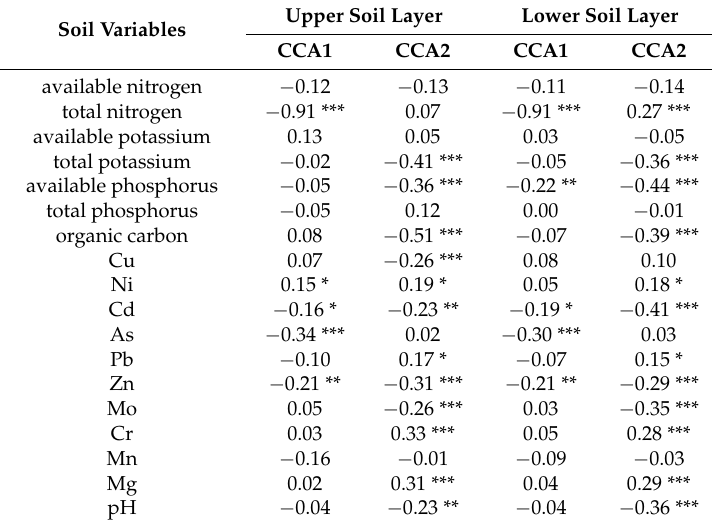
Figure 1. Canonical correspondence analysis (CCA) in two soil layers involving the upper ( a ) and lower layer ( b ). The species abundance and average values of soil nutrients in the 40 m × 40 m plots were used to test the relationship between species composition and soil elements. The species scores and site scores of the first two ordination axes are drawn in the figure. The arrow direction indicates the positive and negative correlation between the soil nutrient and ordination axes, while the length of the arrow represents the degree of correlation between certain soil nutrient variables and the community composition. Table 1. Pearson’s correlations between soil variables and the first two axes of canonical correspondence analysis (CCA).